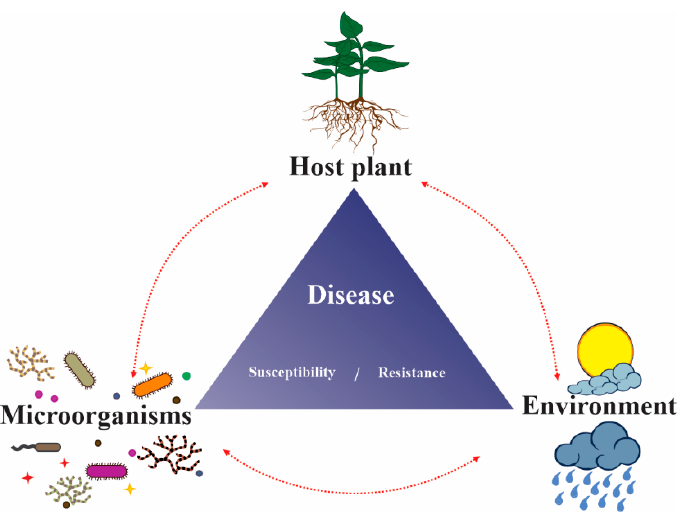
Figure 2. The health and disease triangle. Disease resistance or susceptibility is determined by the host plant, its microbiome and the environment. The composition of the plant microbiome is also influenced by the host plant and environmental factors. Effectors of endophytes and pathogens (left corner, represented by small circles and stars) play a major role in plant health; disease susceptibility or resistance are mediated by these molecules. Effectors are also determinants of the endophyte- pathogen lifestyle continuum and help regulate the composition of the plant microbiome. Lastly, plants regulate the environment through photosynthesis and respiration; microbes are also key components that regulate climate homeostasis.